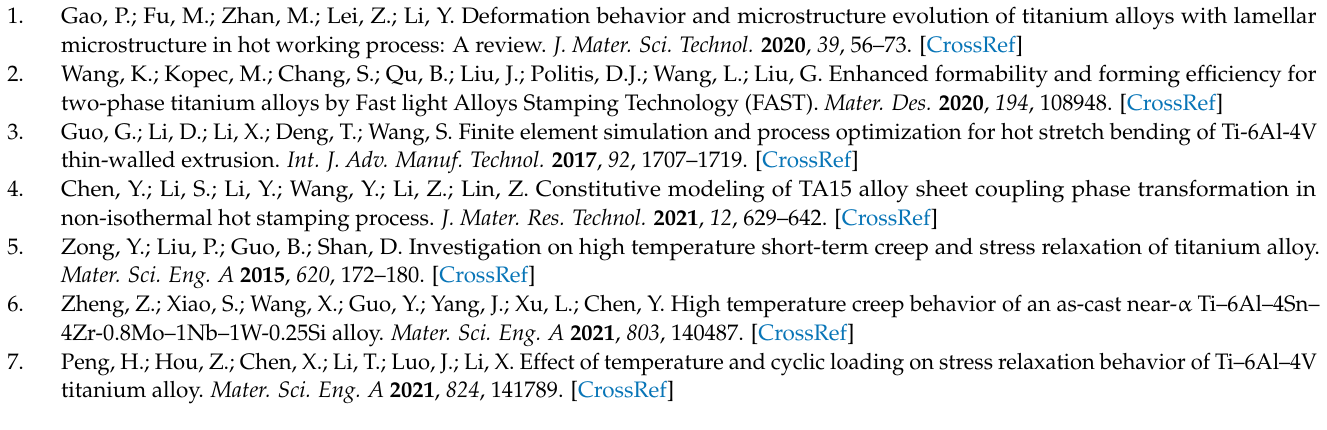
fitted by RSR curves, the value of 𝑄 (cid:2868) (cid:3028)